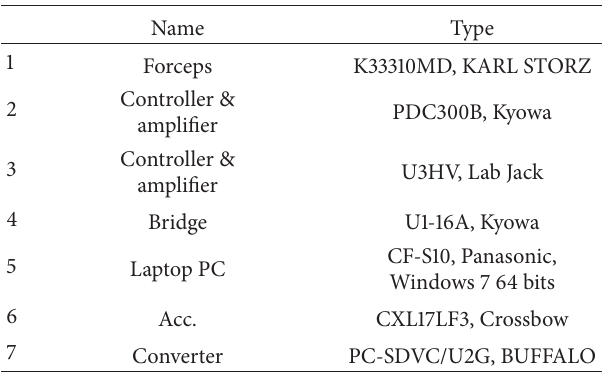
Table 1: The equipment we